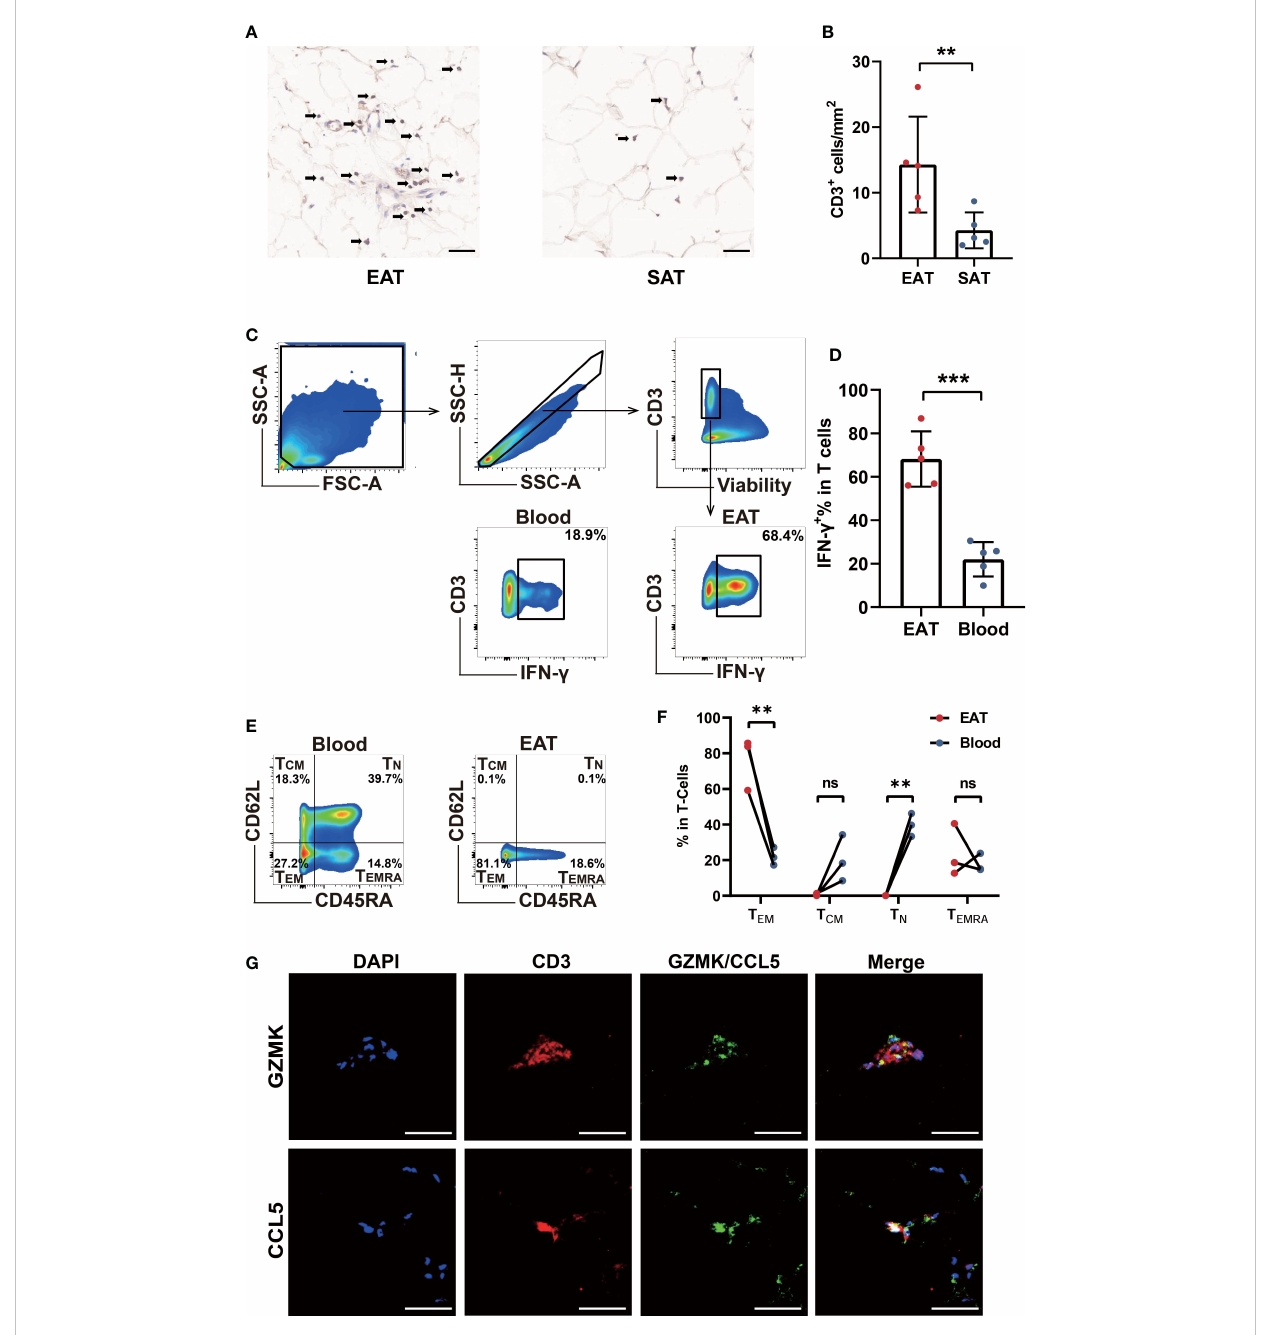
FIGURE 6 Veri fi cation of T cells in fi ltration and key molecules in EAT. (A, B) CD3-speci fi c immunohistochemical staining in EAT and SAT. (C, D) Gating strategy and representative fl ow cytometry results of IFN- g + T lymphocytes in EAT. (E, F) Representative fl ow cytometry results for proportion of T lymphocytes memory subtypes in EAT. (G) Representative fl uorescent staining images of CCL5 and GZMK with CD3 from EAT of HF patients (scale: 50 m m). ** P < 0.01, *** P < 0.001 and ns refers to no signi fi